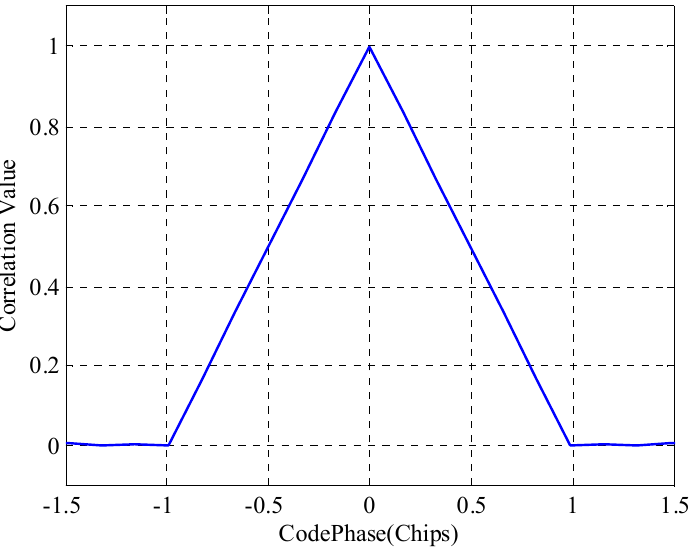
Figure 2. Autocorrelation characteristics of navigation signals.